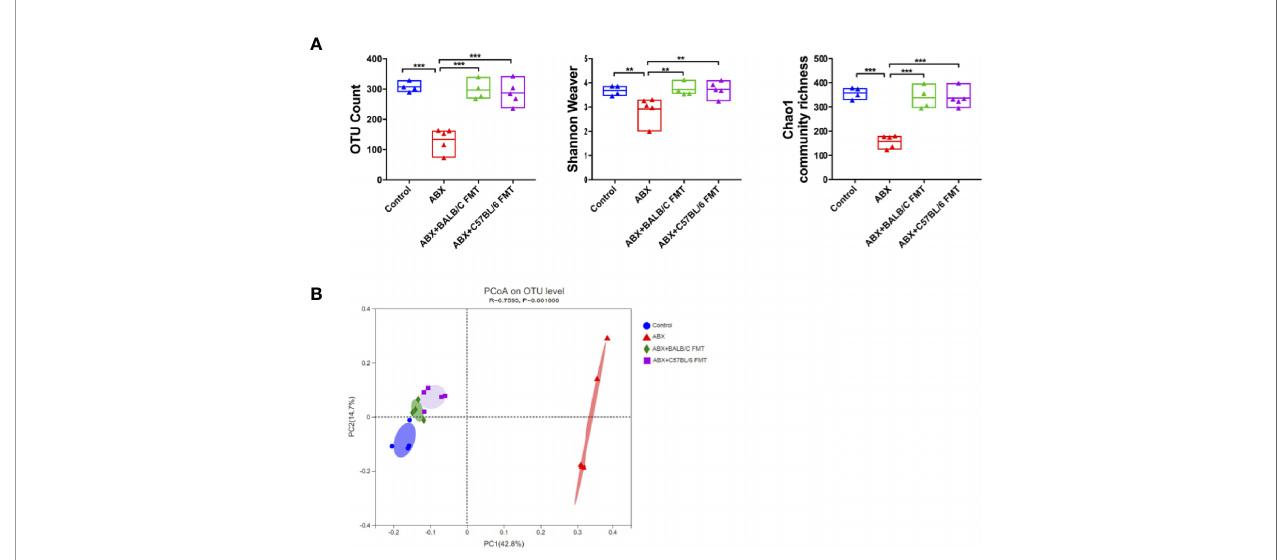
FIGURE 4 | FMT reconstitutes the gut microbiota in BALB/c mice. After FMT (on day 35 as indicated in Figure 3A ), the gut microbiota diversity was assessed based on OTU counts, Chao1 community richness, and the Shannon – Weaver index (A) and Bray-Curtis dissimilarity (B) . n = 4 in control group. n = 5 in ABX, ABX +BALB/c FMT, ABX+C57BL/6 groups. ** P < 0.01, *** P <